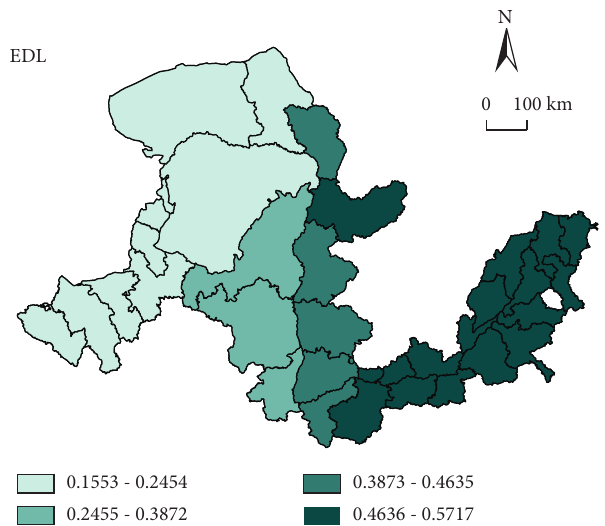
Figure 7: Spatial distribution of regression coefficient of the EDL on